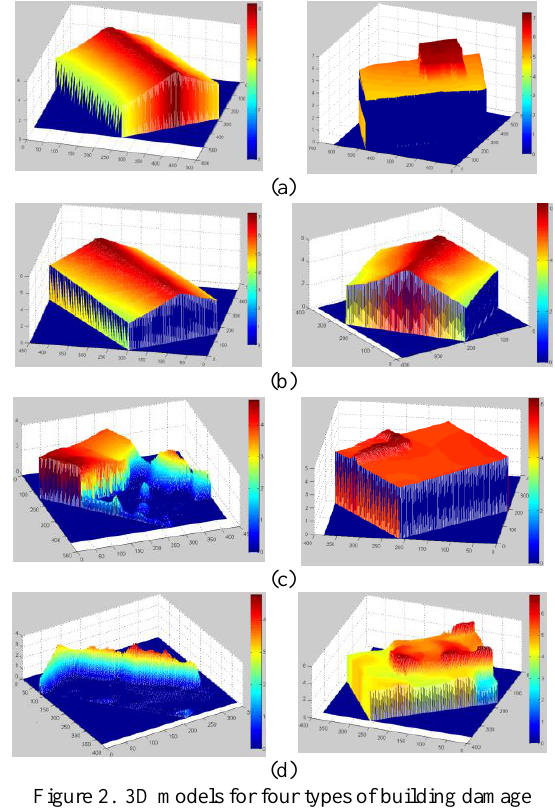
Figure 2. 3D models for four types of building damage classification: (a) basically intact buildings; (b) slightly damage buildings; (c) partially collapsed buildings; (d) totally collapsed buildings.